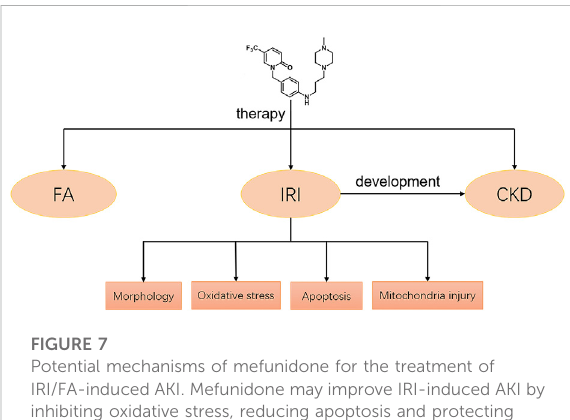
FIGURE 7 Potential mechanisms of mefunidone for the treatment of IRI/FA-induced AKI. Mefunidone may improve IRI-induced AKI by inhibiting oxidative stress, reducing apoptosis and protecting